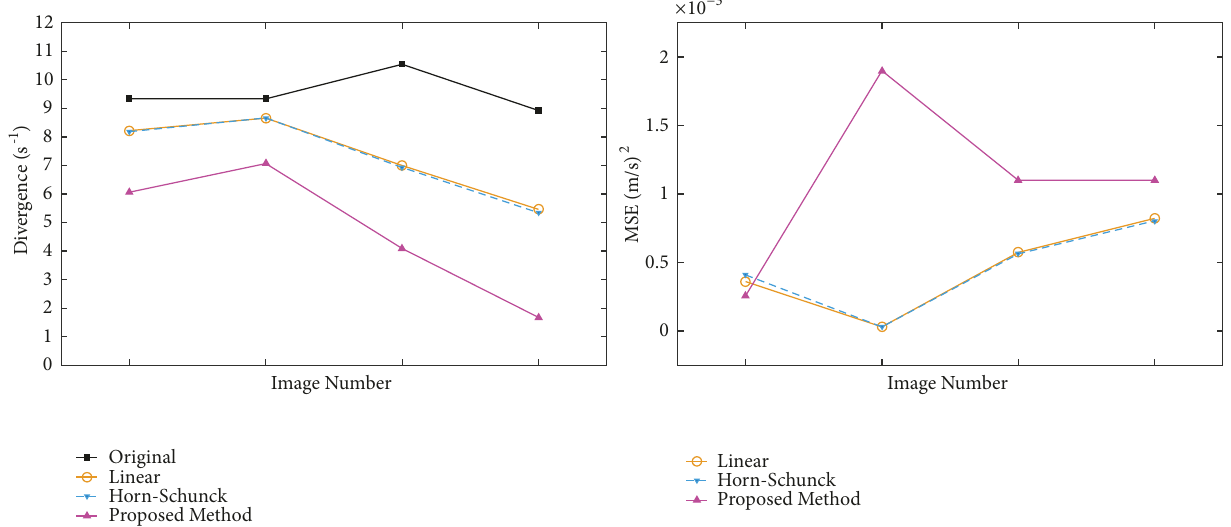
Figure 8: Divergence and MSE comparisons for the CFD